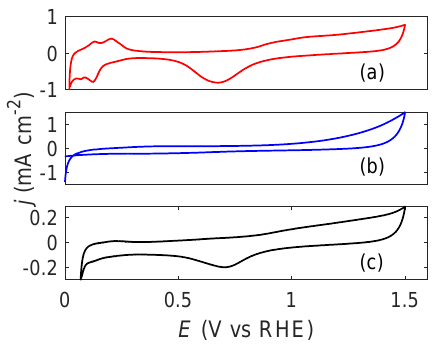
Figure 4. Cyclic voltammograms for sonochemically synthesized carbon supported Pt-nanoparticles ( a ), and Cu-nanoparticles before ( b ) and after ( c ) the addition of PtCl 4 . All measurements were performed in 0.5moldm − 3 H 2 SO 4 with a scan rate of 50mVs − 1